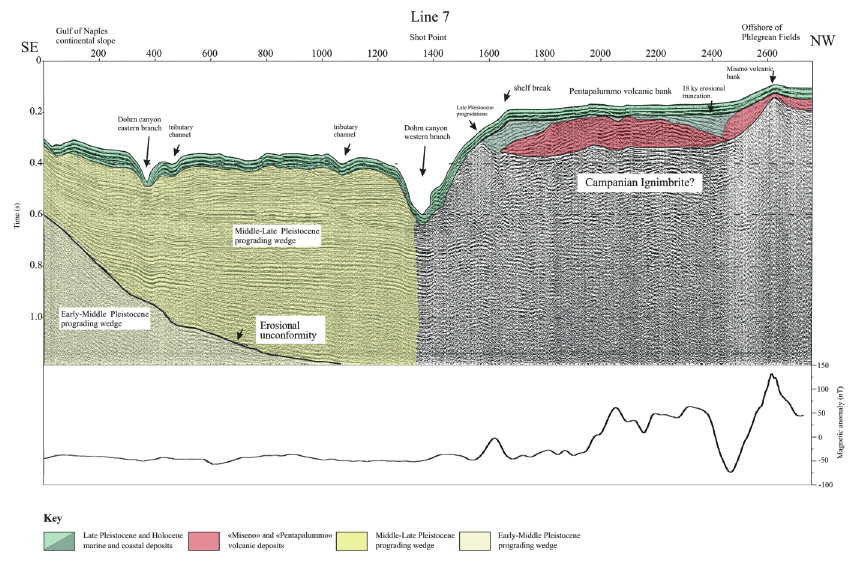
Fig. 7. Seismic profile GR51 and corresponding interpretation. The relative magnetic profile is reported in the inset. Several main magnetic anomalies have been identified on this profile corresponding to main volcanic bod- ies offshore the Phlegraean Fields volcanic complex (see on the right in seismic and magnetic profile). A first pronounced anomaly, in the order of 130 nT correlates to the Miseno volcanic bank. A large, terraced anomaly with a relative intensity of 100 nT is related to the Pentapalummo volcanic bank, whose external sector is crossed by the GR51 line. The terraced shape of the anomaly reflects in some way the bathymetric setting of the bank, characterized by a terraced top reaching water depths of –50 m. The flat trending of the magnetic profile con- firms the occurrence of sedimentary packages on the Gulf of Naples continental slope, deeply eroded by two branches of the Dohrn